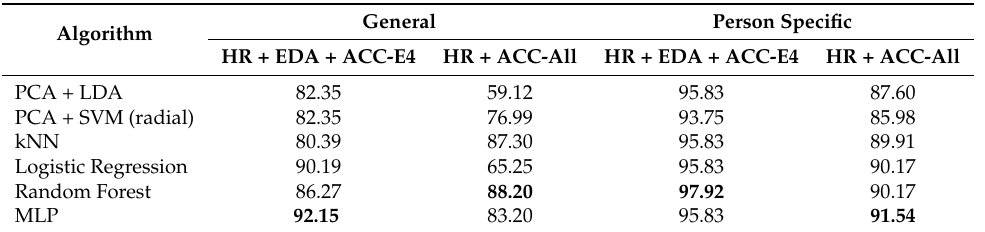
Table 12. Classification accuracies of general and person-specific models.